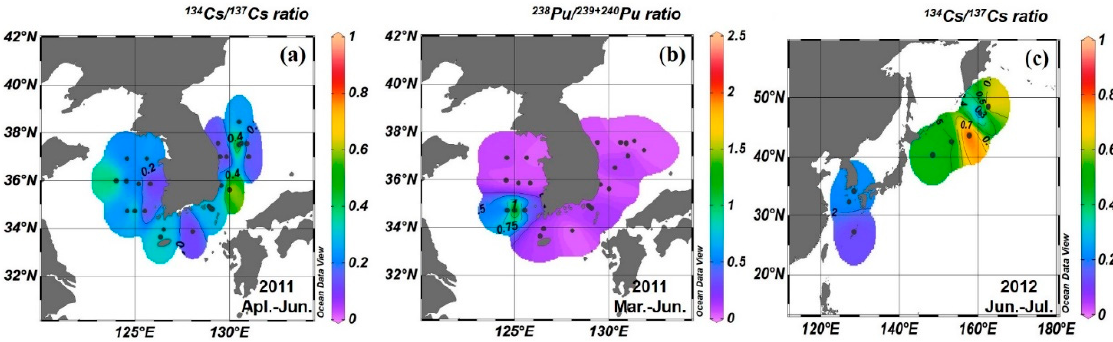
Figure 6. The activity ratios: ( a ) 134 Cs/ 137 Cs in the Korean seas (2011); ( b ) 238 Pu/ 239+240 Pu (2011) in the Korean seas; and ( c ) 134 Cs/ 137 Cs in the North Pacific (2012).